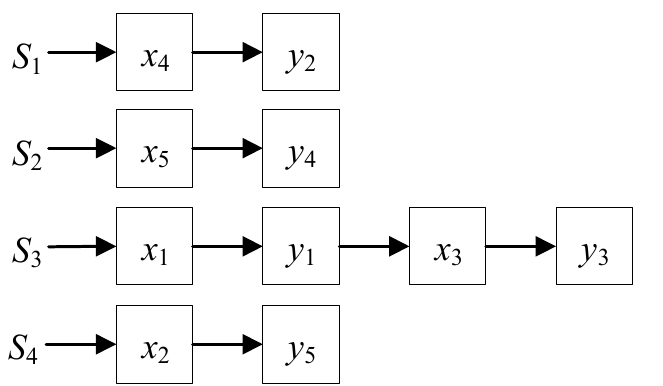
Figure 3. AGVs’ scheduling sequence.